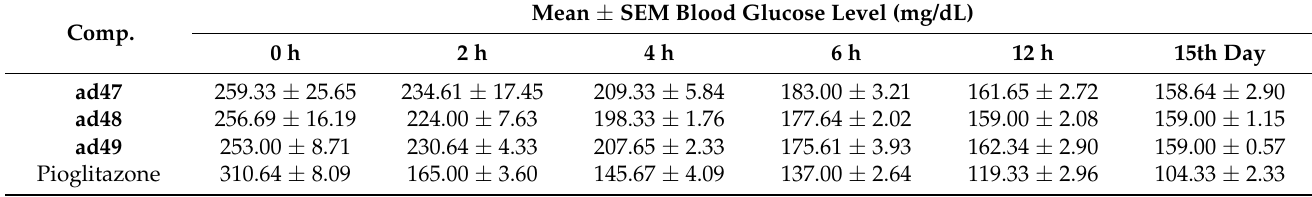
Table 52. Antidiabetic potential of the compounds ( ad52 – ad54 ). Comp.